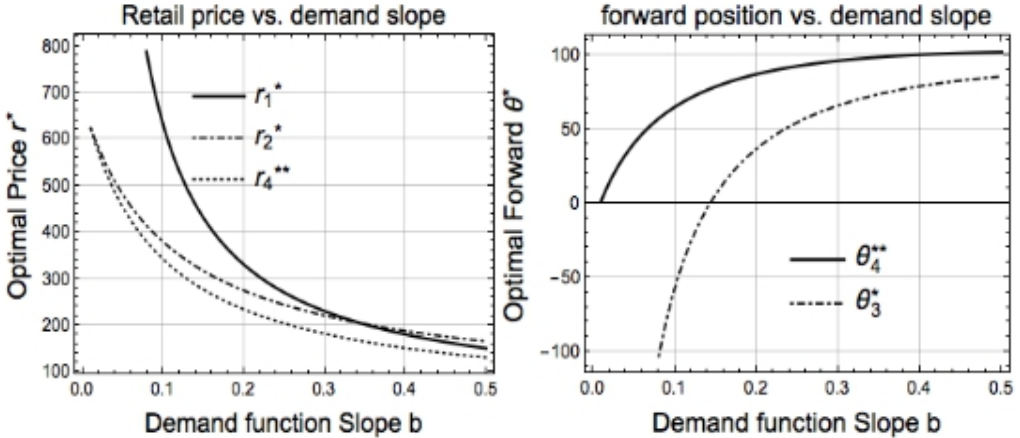
Figure 12. Comparison of r (cid:2869)∗ , 𝑟 (cid:2870)∗ , and 𝑟 (cid:2872)∗∗ from Theorems 1, 2, and 4 as a function of the demand slope b (left panel), and θ (cid:2872)∗∗ and 𝜃 (cid:2871)∗ from Theorems 4 and 3 as a function of the demand slope b (right panel).